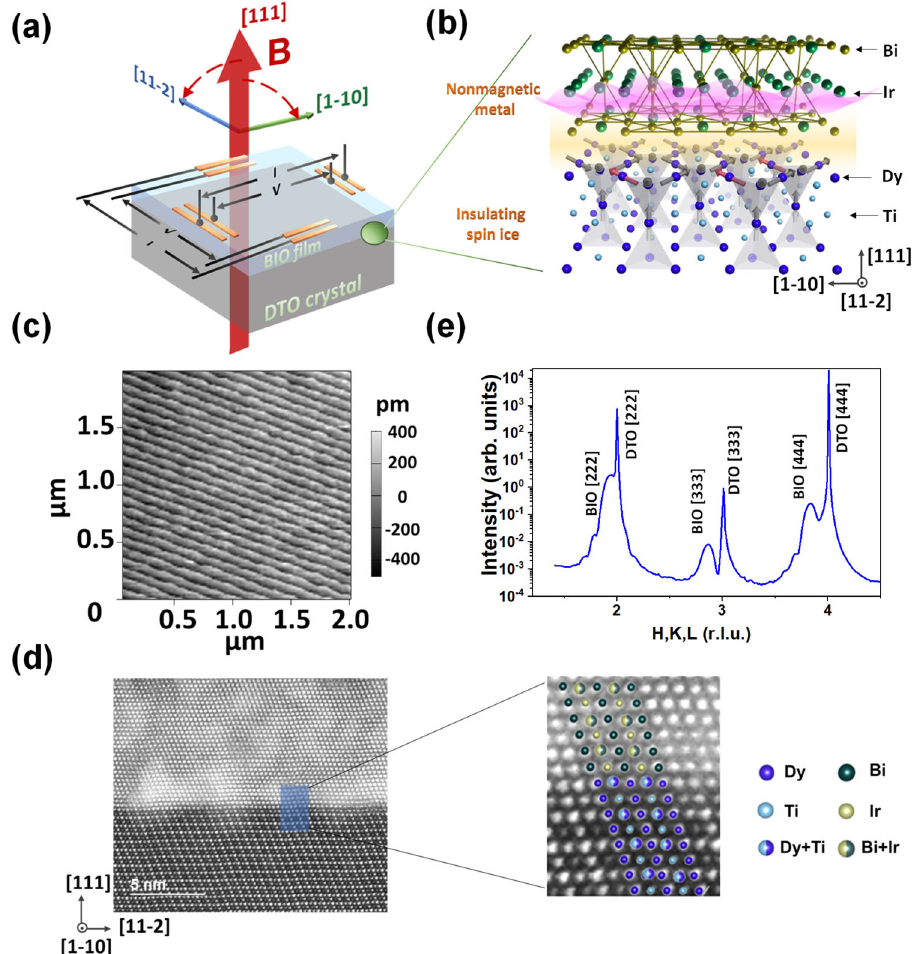
Fig. 1 | Bi 2 Ir 2 O 7 /Dy 2 Ti 2 O 7 heterostructure. a Schematic diagram of the Dy 2 Ti 2 O 7 / Bi 2 Ir 2 O 7 heterostructure and the measurement con fi guration. b A schematic drawing showing a zoomed region across the interface. The local spins (gray)